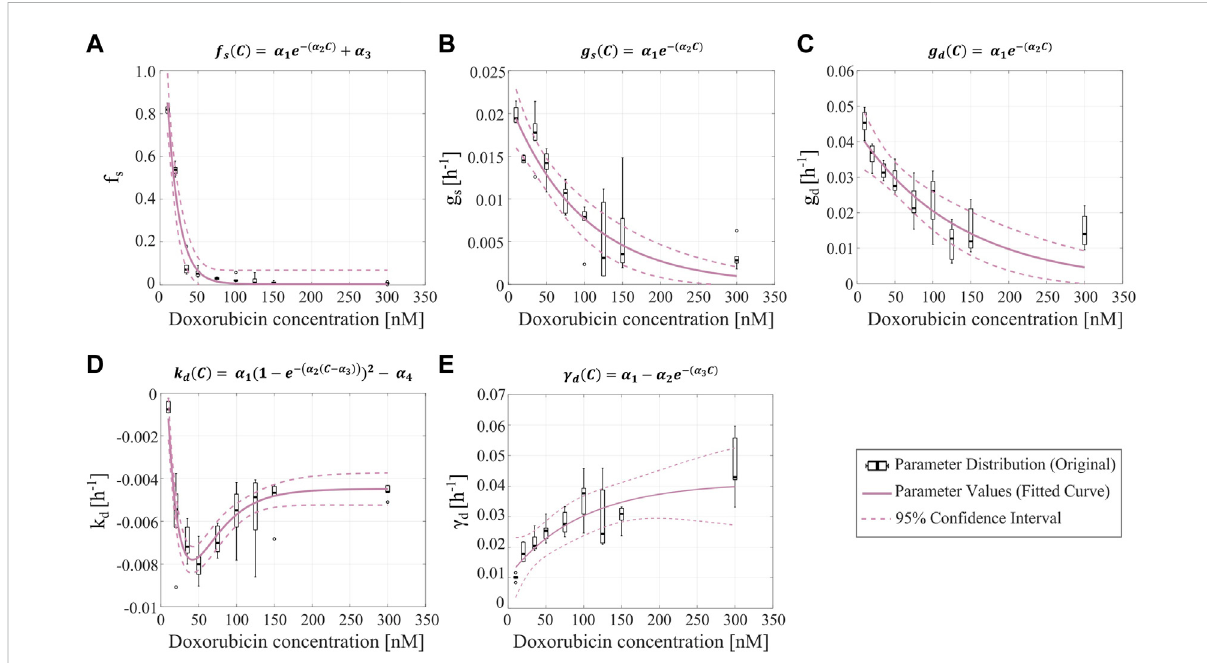
FIGURE 3 Empiricalparameterformulasforvaryingdoxorubicinconcentrations.Theproposedempiricalformulasindicatedatthetopofeachpanel (A – E) were fi t to the median of the corresponding parameter distributions obtained from fi tting the single-dose model to the varying concentration datasets from Experiment 1 (Table 1). C denotes doxorubicin concentration in nM, while α i ( i (cid:1) 1 , 2 , ... ) are empirical parameters. The distributions of the single-dose model parameters are represented with black boxplots, in which outliers are represented as black circles. The resulting curves from fi ttingtheempirical parameter formulasare shownas purplesolidlines, andtheir corresponding95% con fi denceintervals areplotted aspurple dashedlines. Panel (A) showstheparameterformulaforthefractionofsurvivingcells( f s ).Panel (B) showstheparameterformulafortheproliferation rate of the surviving tumor cells ( g s ). Panel (C) shows the parameter formula for the proliferation rate of the irreversibly damaged tumor cells ( g d ). In panels (A – C) , we observe that as the drug concentration increases, the corresponding single-dose model parameter values decrease exponentially. Panel (D) shows the parameter formula for the doxorubicin-induced death rate of irreversibly damaged cells ( k d ), which we approximated with an equationbasedonaMorse-potentialrelationship.Panel (E) showstheparameterformulaforthedoxorubicin-induceddeathdelayrateofirreversibly damagedcells( γ d ),whichincreasesandthenplateausasthedrugconcentrationincreases.Medianandrangeofqualityof fi tmetricsfortheempirical parameter formulas ( n = 5) are NRMSE: 17.65 [5.45, 153.6], R 2 : 0.91 [0.78, 0.98], PCC: 0.95 [0.88, 0.99], and CCC: 0.85 [0.78,